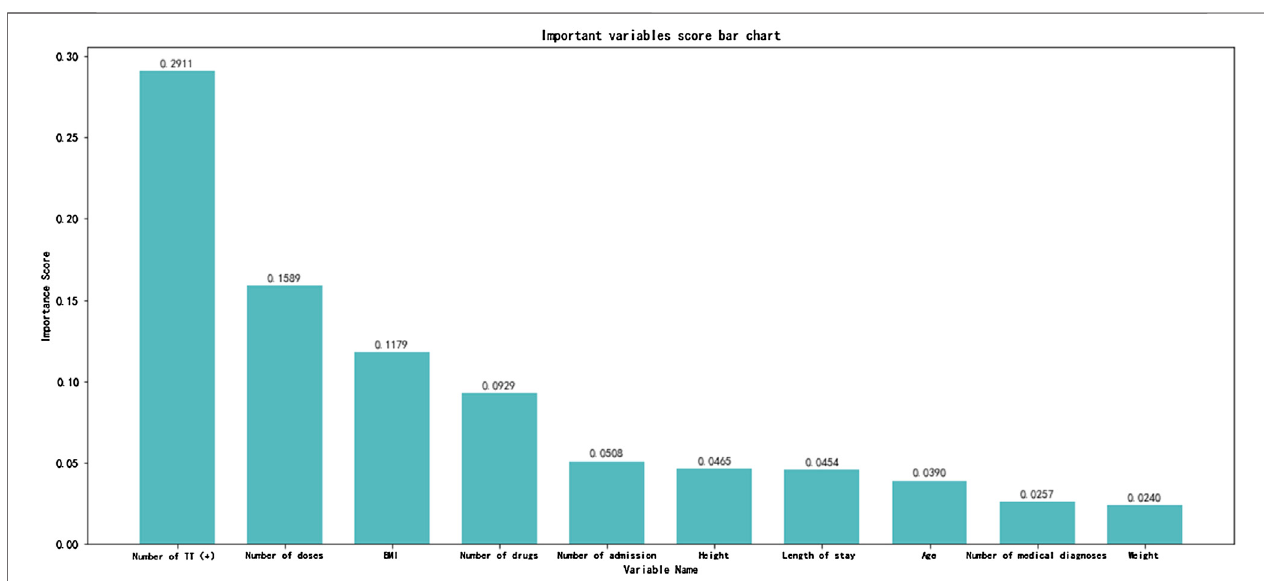
FIGURE 1 | Importance score ranking for risk